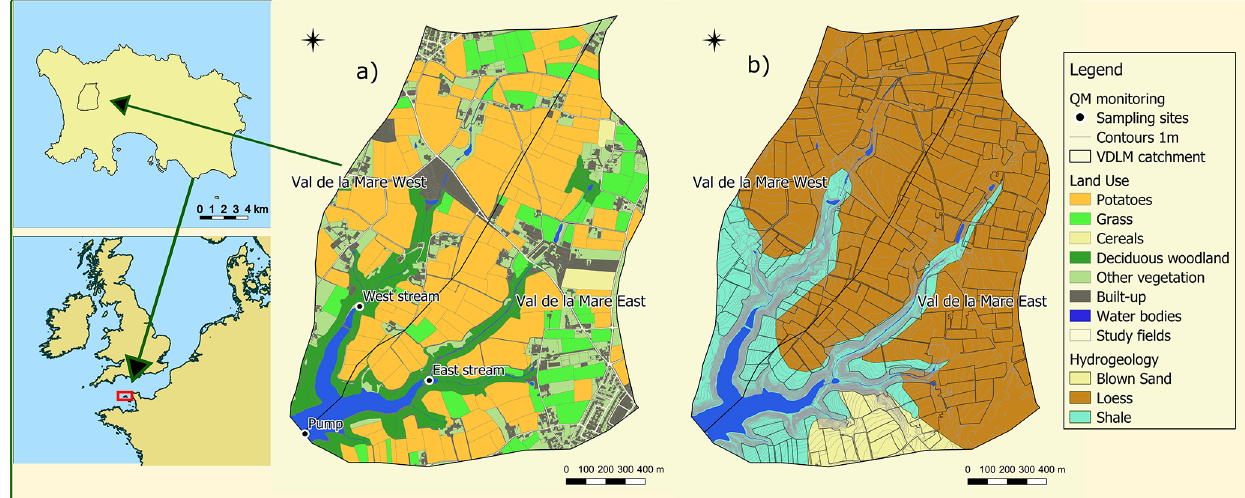
Figure 1. Location of the Val de la Mare (VDLM) study catchment on the island of Jersey. Panel (a) shows the three water quality monitoring sites (Pump, West stream, and East stream) and the land use in the catchment, and panel (b) shows the hydrogeology. Country boundaries were taken from https://www.gadm.org/ (last access: 24 February 2022), and hydrogeological data were digitised from the Hydrogeological map of Jersey available under the Open Government Licence v3.0 (contains © British Geological Survey materials, UKRI,